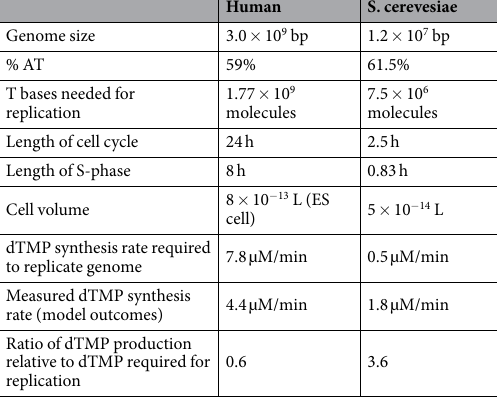
Table 12. Cellular capacity for de novo dTMP synthesis in mammals and yeast at